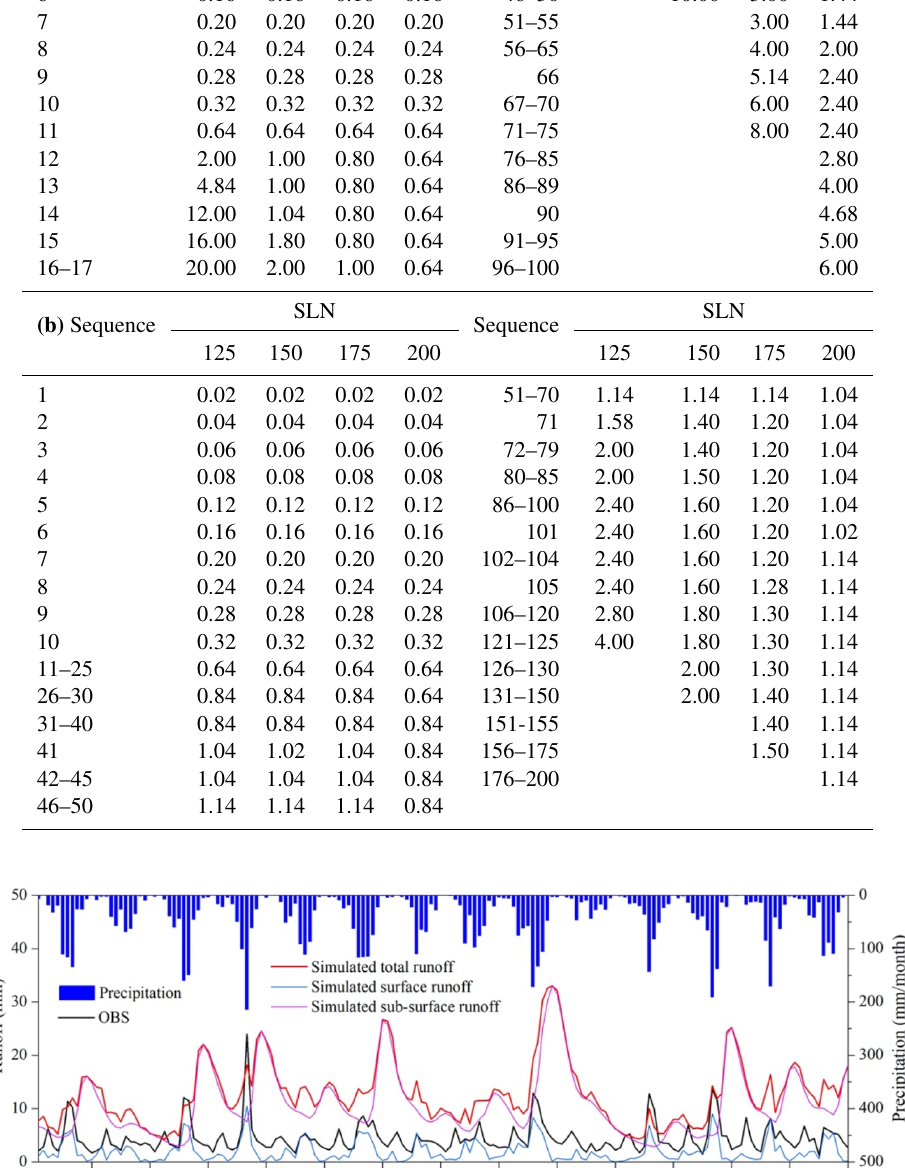
Figure 2. Observed monthly precipitation and runoff (black line) and simulated total runoff, surface runoff, and subsurface runoff in the default run from 1956 to 1969. The observed monthly precipitation is for the entire WRB, and the OBS (observations) and simulations are for the BJC hydrological